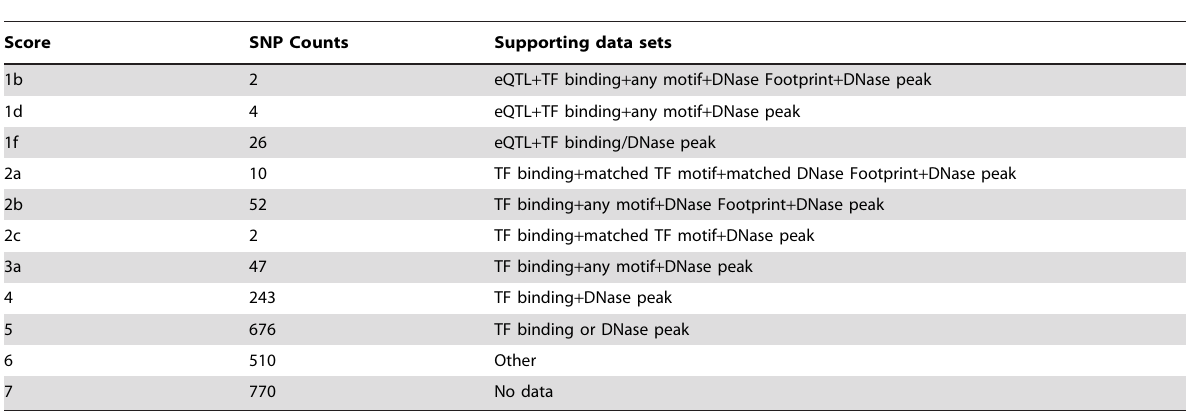
Table 6. Overview of RegulomeDB